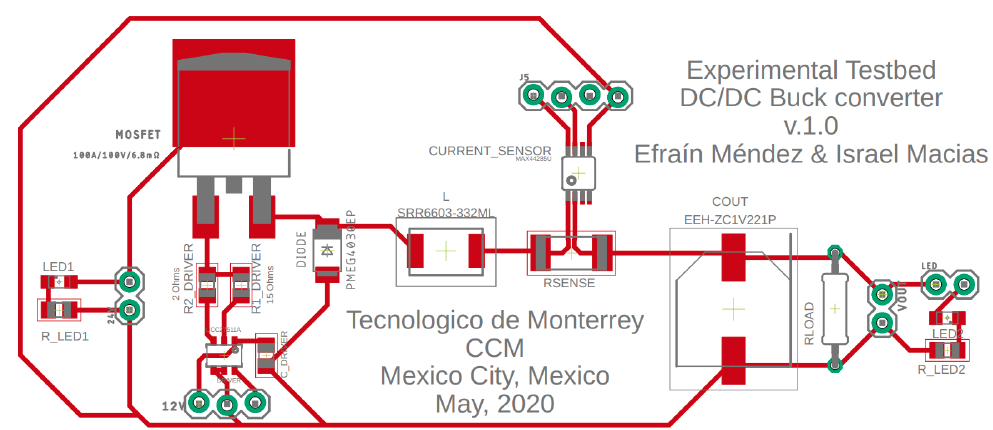
Figure 15. Printed Circuit Board (PCB) design of the experimental